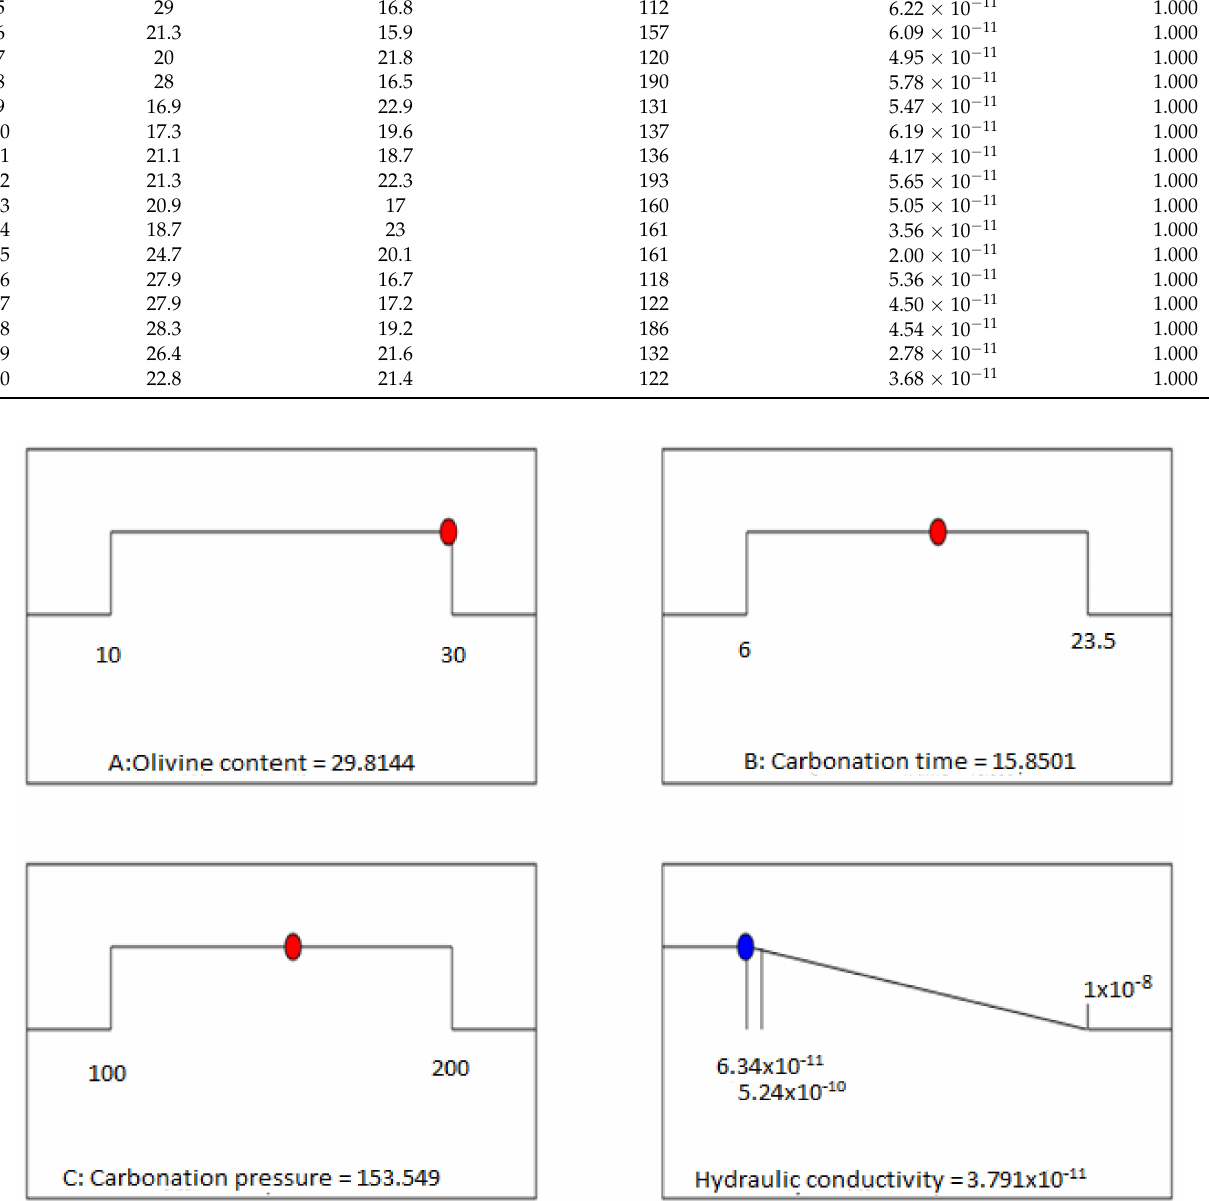
Figure 13. Desirability ramp for numerical optimization for the selected goals for solution number